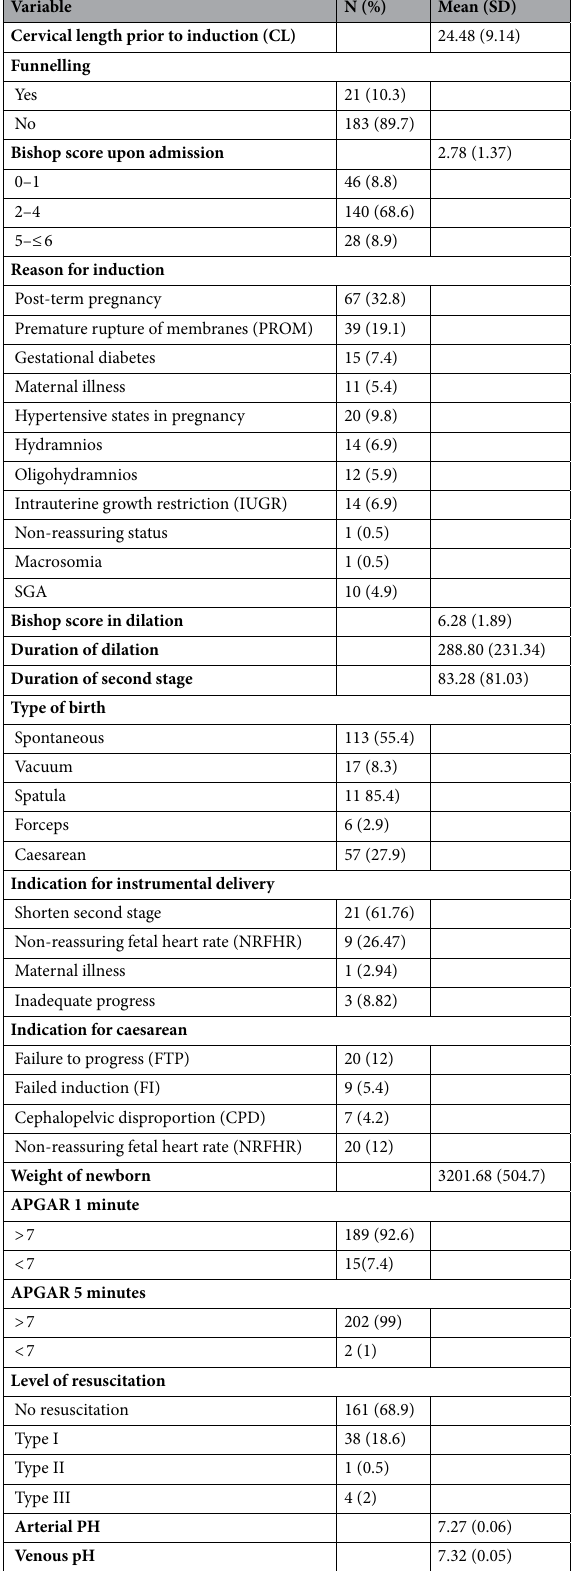
Table 1. Sociodemographic and obstetric variables